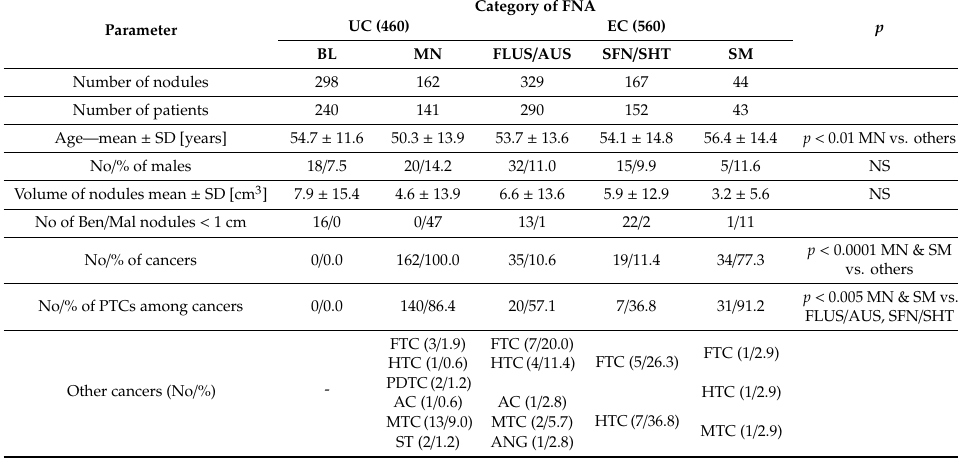
Table 1. Demographic data of the patients and the percentage of cancers revealed in the nodules with unequivocal (UC) and equivocal (EC) FNA